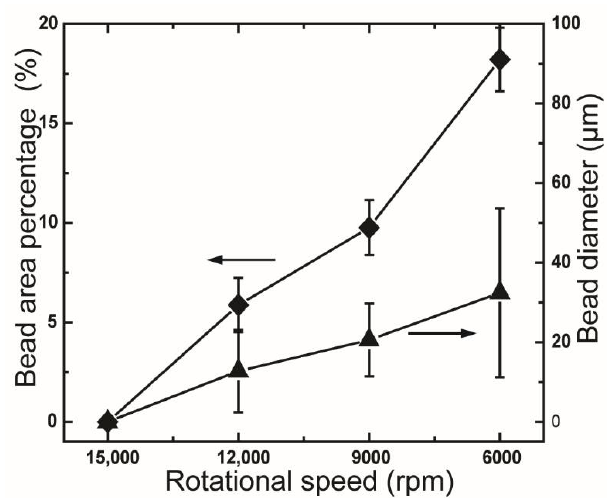
Figure 6. Bead area percentage and bead diameter of rPET mats fabricated under various rotational speeds. Centrifugal spinning condition: polymer solution concentration, 10 wt %; needle inner diameter, 160 μm; collection distance, 10 cm.